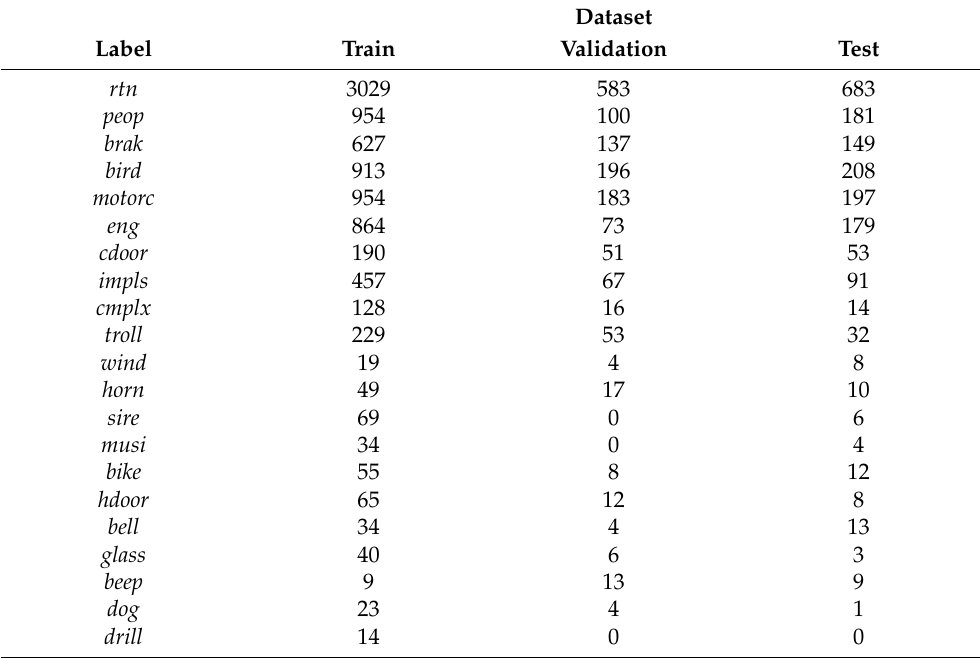
Table 2. Number of events on the Train, Validation, and Test